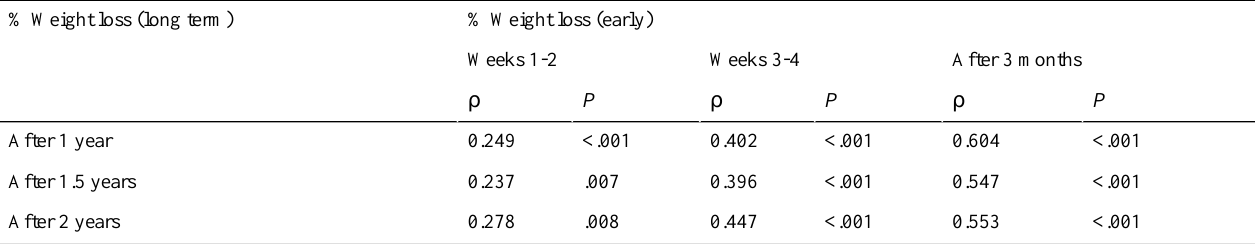
Table 5. Spearman correlations ( ρ ) between early weight loss and weight maintenance in the study sample.